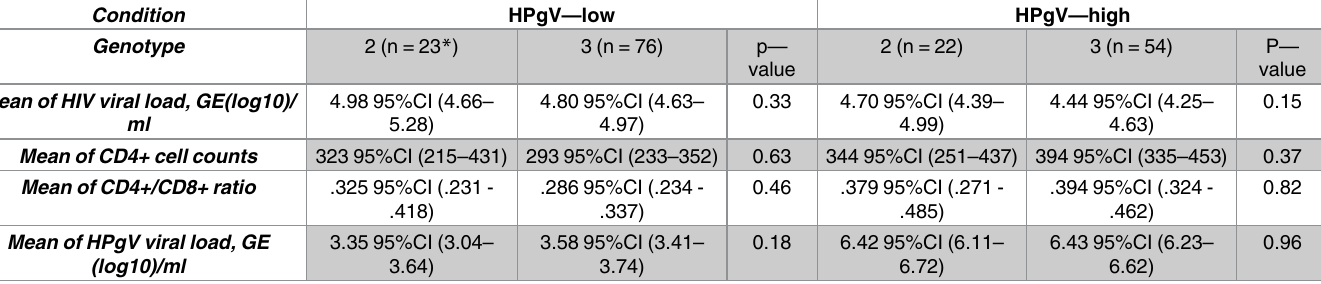
Table 1. Surrogate markers of HIV progression compared between genotypes 2 and 3, according to the low or high HPgV viral loads in HIV-posi- tive ART-na ï ve patients. Condition